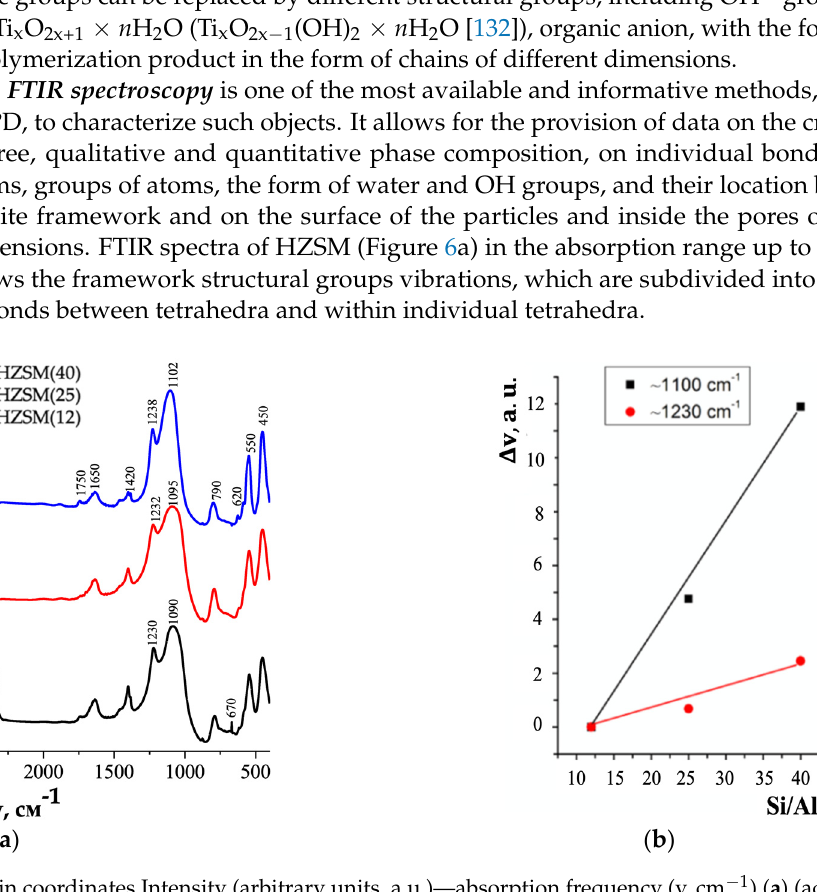
Figure 6. FTIR spectra of HZSM in coordinates Intensity (arbitrary units, a.u.)—absorption frequency (v, cm − 1 ) ( a ) (adapted from [16]); dependence of the wavelength change ( Δ v, a.u.) on HZSM (12, 40, 300) silicate modulus (Si/Al) value ( b ).